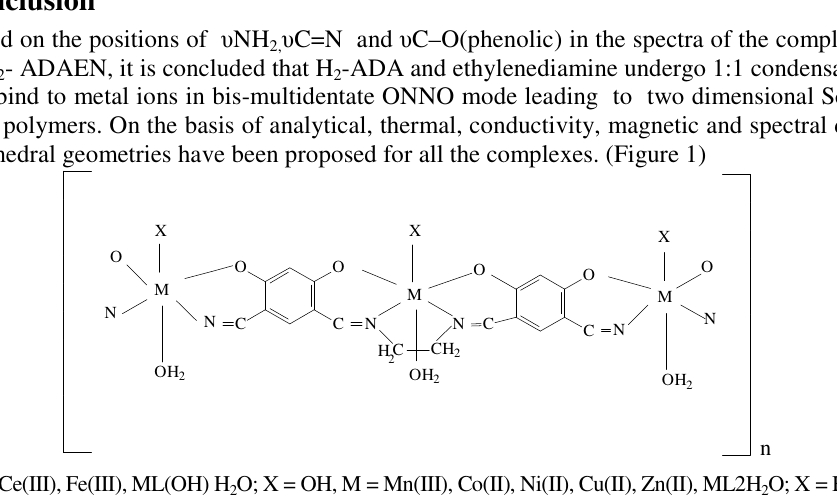
Figure 1. Complexes of H